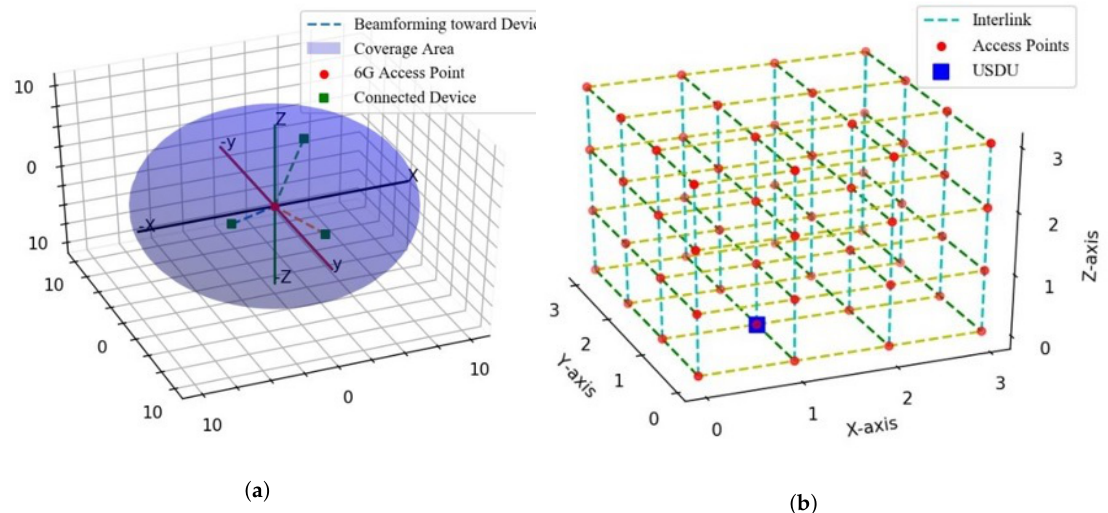
Figure 8. Three-dimensional multilayer network connectivity. ( a ) Coverage of 6G access point in x , y , and z , and ( b ) 3D connectivity of multiple 6G access points.